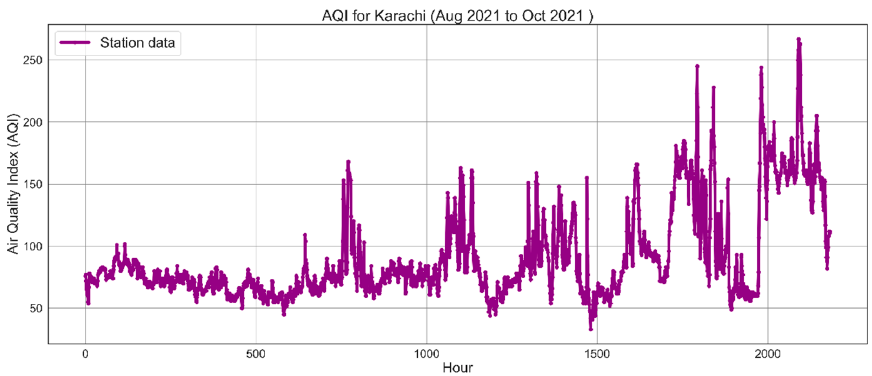
Figure 3. AQI data from the monitoring station for Karachi City. Table 2. Information about the dataset of samples.